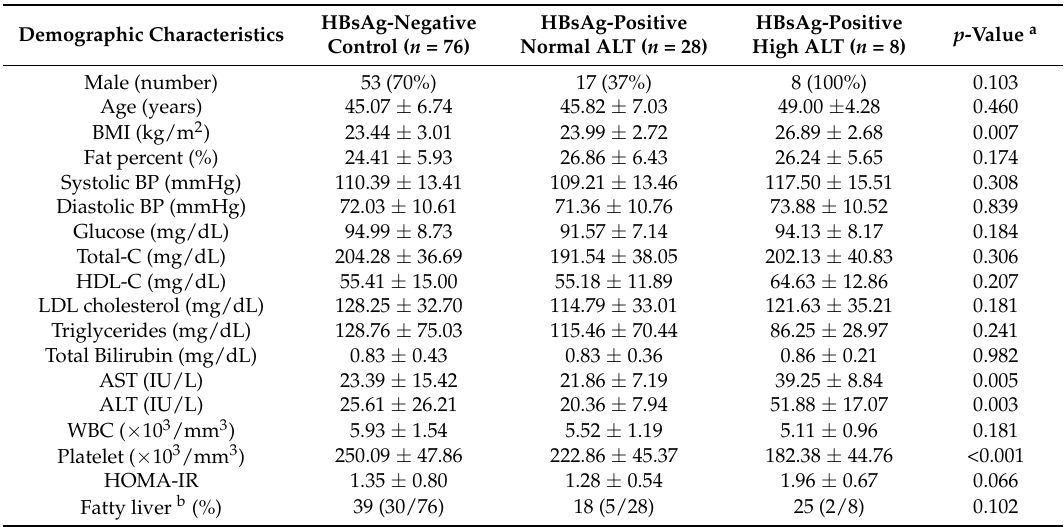
Table 1. Characteristics of the studied